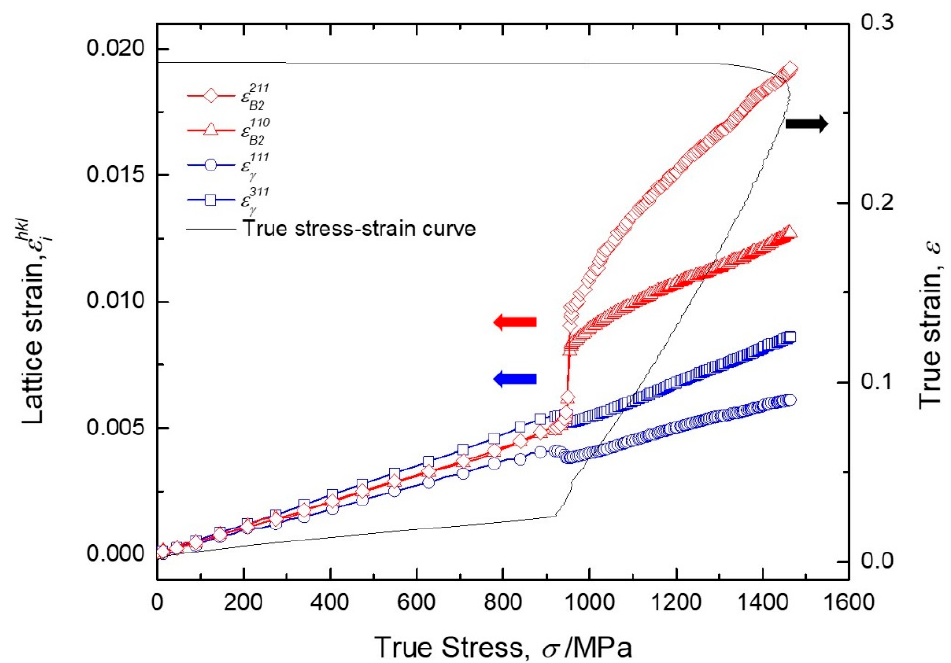
Figure 6. Changes in the (111) and (311) lattice strains of austenite phase, and the (110) and (211) lattice strains of B2 phase as a function of tensile true stress. The true stress-strain curve is superimposed in the figure. The lattice strain after tensile fracture is not shown in the figure for the sake of simplicity.